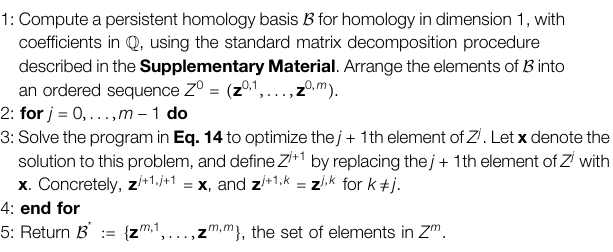
Algorithm 1 | Edge-loss persistent cycle